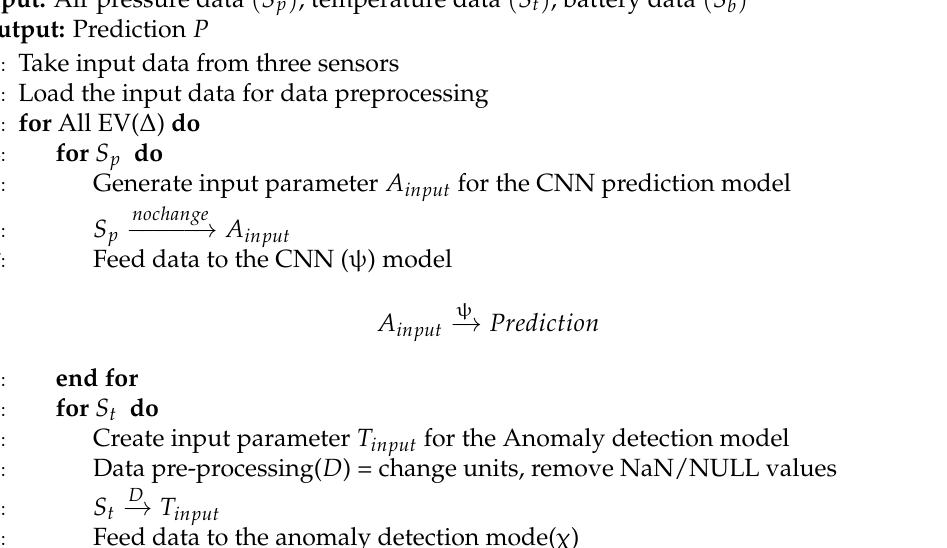
Algorithm 1 Prediction model